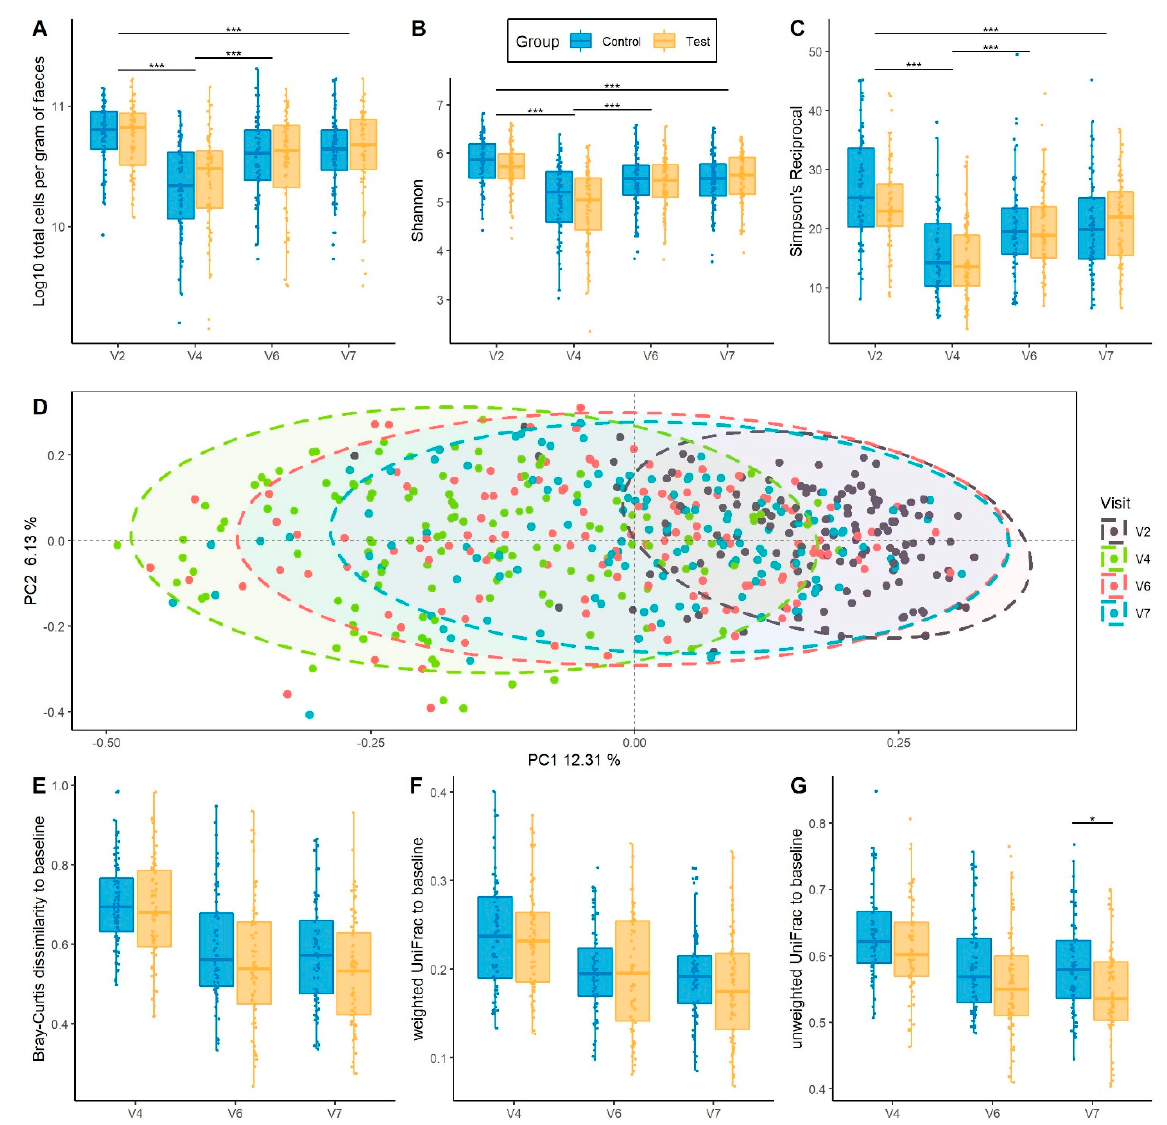
Figure 2. Global gut microbiota response to Hp treatment and product intervention. ( A ) Total bacterial count/g fecal samples assessed by flow cytometry, with a log 10 transformation. ( B ) Alpha-diversity assessed by Shannon index ( C ) Alpha-diversity assessed by Simpson’s Reciprocal. ( D ) Principal Coordinate Analysis (PCoA) based on Bray–Curtis dissimilarity. Samples were collected before (V2) and after Hp treatment (V4), 14 days (V6) and 28 days (V7) following cessation of Hp treatment. * p < 0.05 and *** p < 0.001 according to linear mixed model. ( E – G ) Intra-subject distance to baseline of each subject in Test and Control groups across the study ( E ) Bray–Curtis dissimilarity ( F ) Weighted UniFrac distance ( G ) Unweighted UniFrac distance. * p < 0.05 and *** p < 0.001 according to Mann–Whitney test.